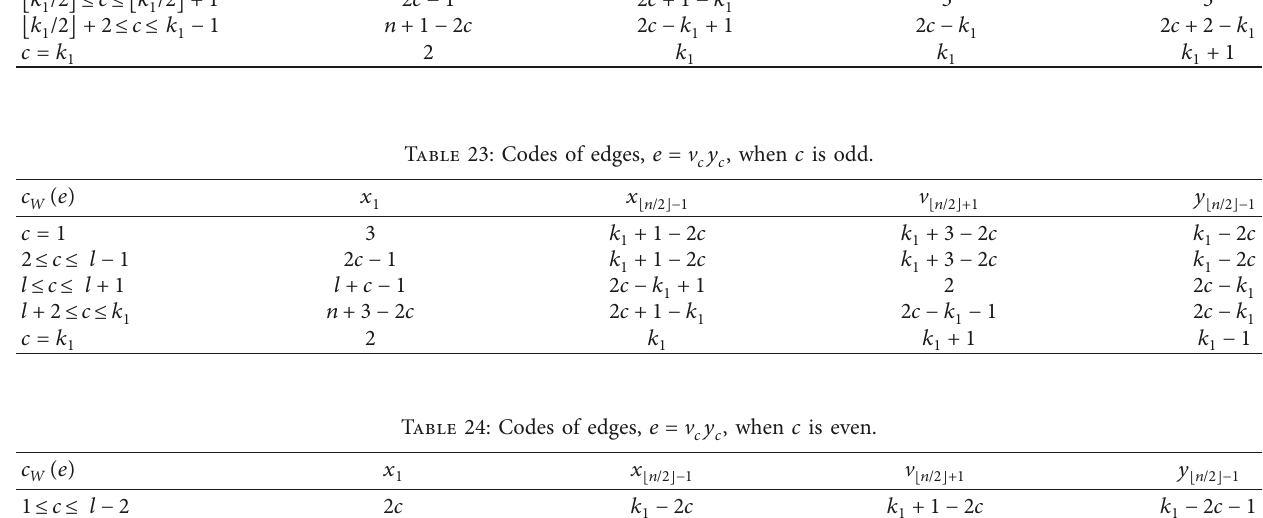
Table 22: Codes of edges, e � x